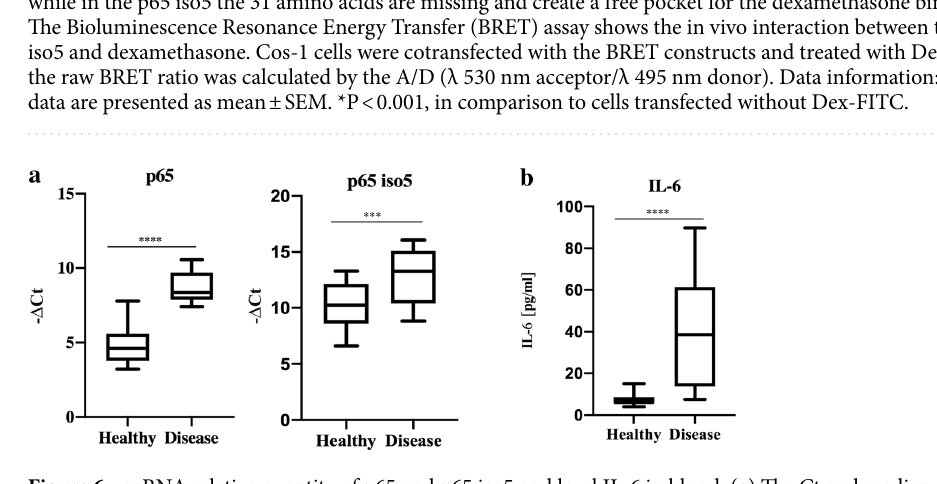
NF-kB is involved in the regulation of inflammatory response, we analyzed the p65 protein profile in inflam- mation liver disease by coupling two-dimensional polyacrilacrylamide gel electrophoresis (2D-PAGE) 44,45 and western blotting. As control, the expression profile of p65 iso5 protein was analyzed in transfected Cos-1 and HeLa cell lines with two different antibodies specific for the NH 2 and COOH epitopes (Fig. 7a). Subsequently, we investigated the expression of p65 iso5 in the hepatocarcinoma cell lines HepG2 and HUH7 (Fig. 7b) and in liver extracts isolated from cirrhosis and HCC patients using healthy condition as control for the identification of p65 and p65 iso5 products (Fig. 7c). A more complex isoelectrofocusing pattern for p65 isoforms was shown in HCC and cirrhosis patients in comparison with control condition. The 2D-PAGE analysis, based on predicted isoelec- tric point (pI) and molecular weight (Mw), shows that these patterns (Fig. 7d) are compatible with the presence of the p65 iso5 and p65 protein in pathological samples, while only p65 is detected in healthy control samples (Fig. 7c). The functional characteristics of the protein encoded by this spliced mRNA are very different from the ones of the canonical p65. Such as the p65 wt, p65 iso5 mRNA is expressed in every mouse and human tissue